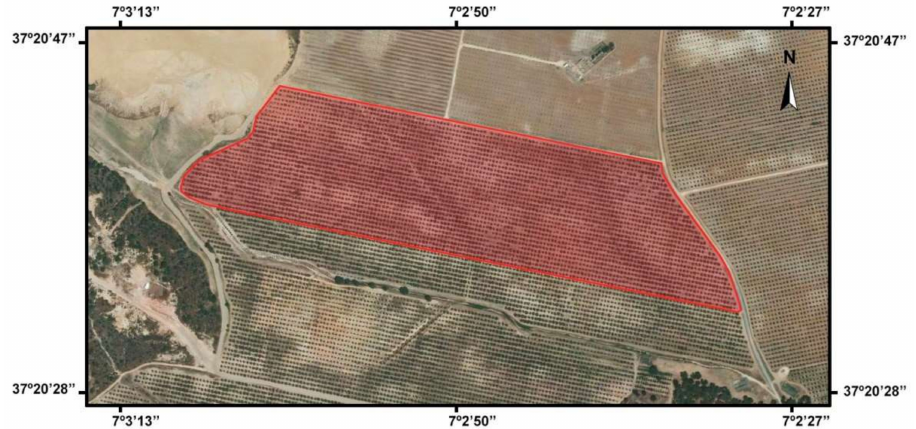
Figure 1. Third-party aerial capture of the case study site shown to illustrate the study plot, highlighted in